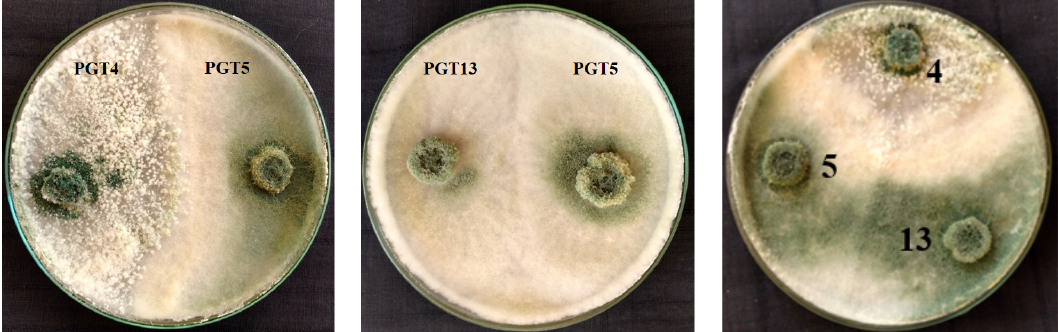
Figure 1. Co-culture of Trichoderma spp. plates showing the compatibility: 4— Trichoderma harzianum , 5— Trichoderma reesei and 13— Trichoderma reesei .